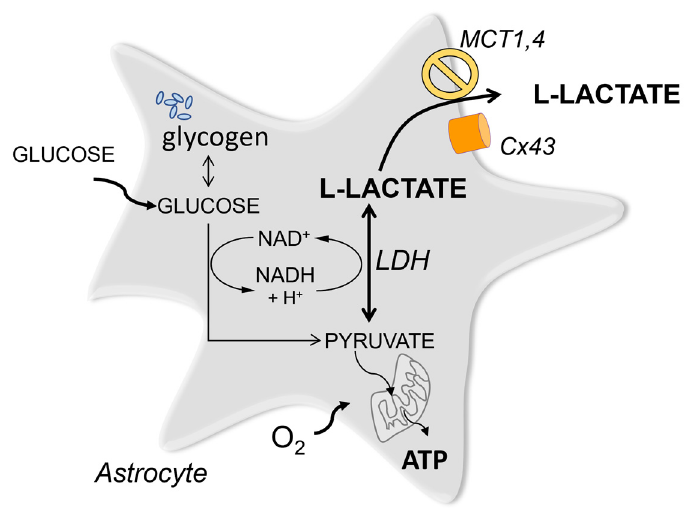
Figure 1. Interconversion of lactic and pyruvic acid is mediated by LDH and recovers NAD + used in glycolysis. Glucose for glycolysis is imported from the periphery or/and recruited from glycogen under conditions that stimulate glycogenolysis.